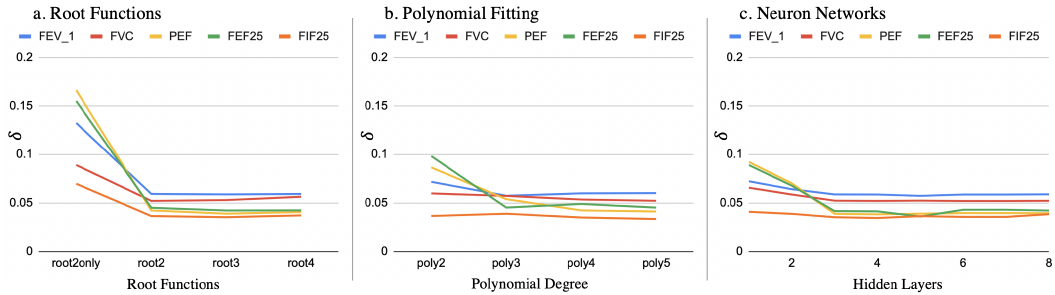
Figure 14. δ of evaluating pulmonary FVC vital parameters between The barometer and The spirometer for The root functions ( a ), polynomial fitting ( b ) and neuron networks ( c